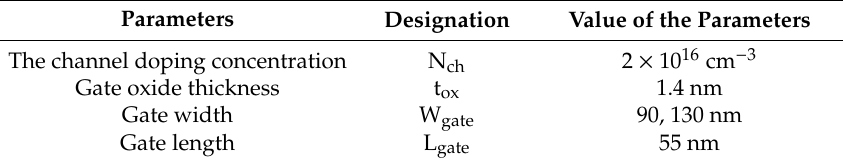
Table 1. The parameters of the simulated MOSFET.